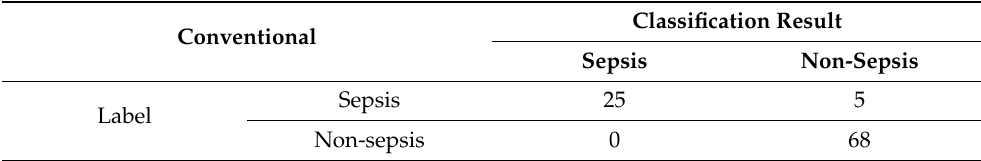
Table 5. Confusion matrix of conventional transfer learning method [4]. Classification accuracy achieved 94.9% (93/98).